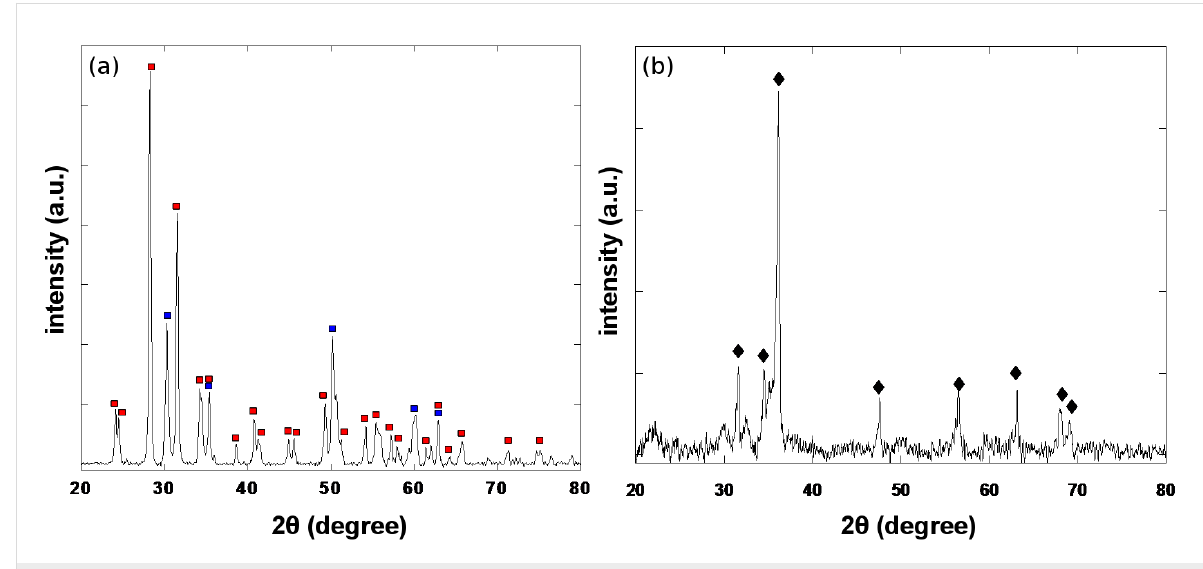
Figure 1: (a) XRD pattern of ZrO 2 precursor, (b) XRD pattern of the synthesized zirconium product after acid